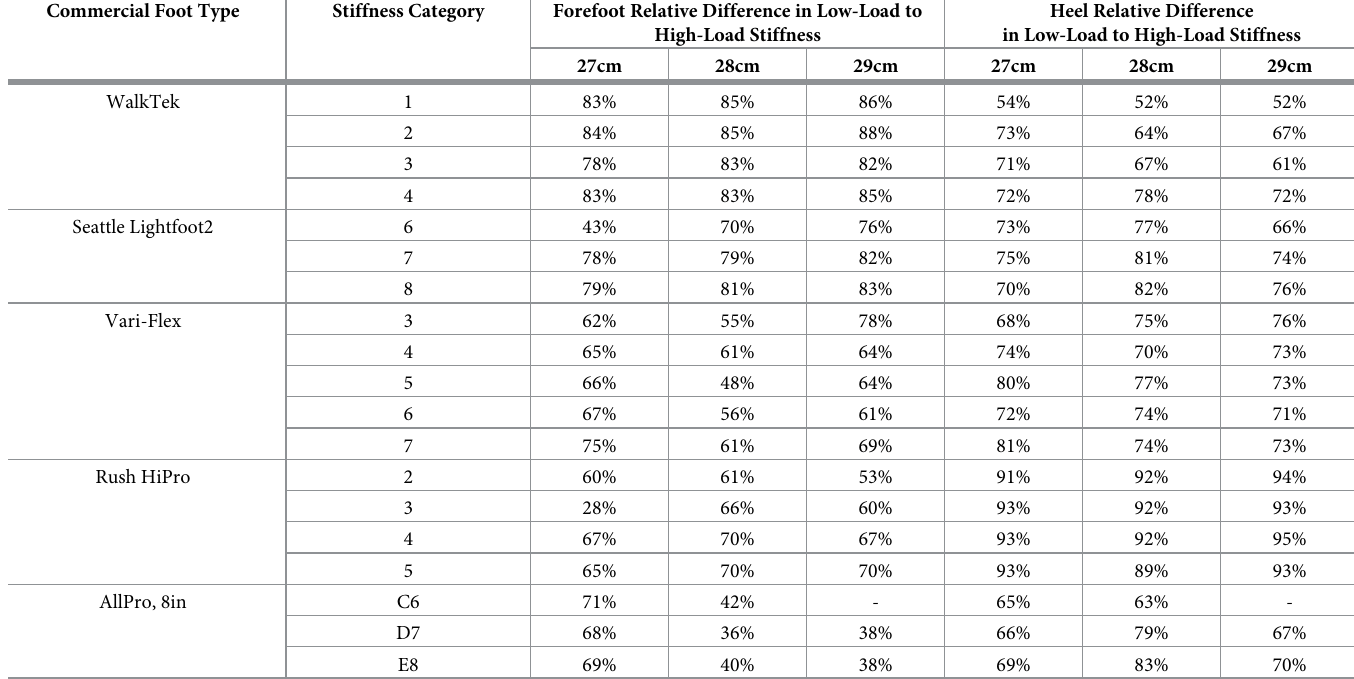
Table 4. Relative percentage differences of low-load compared to high-load stiffness behavior. Commercial Foot Type